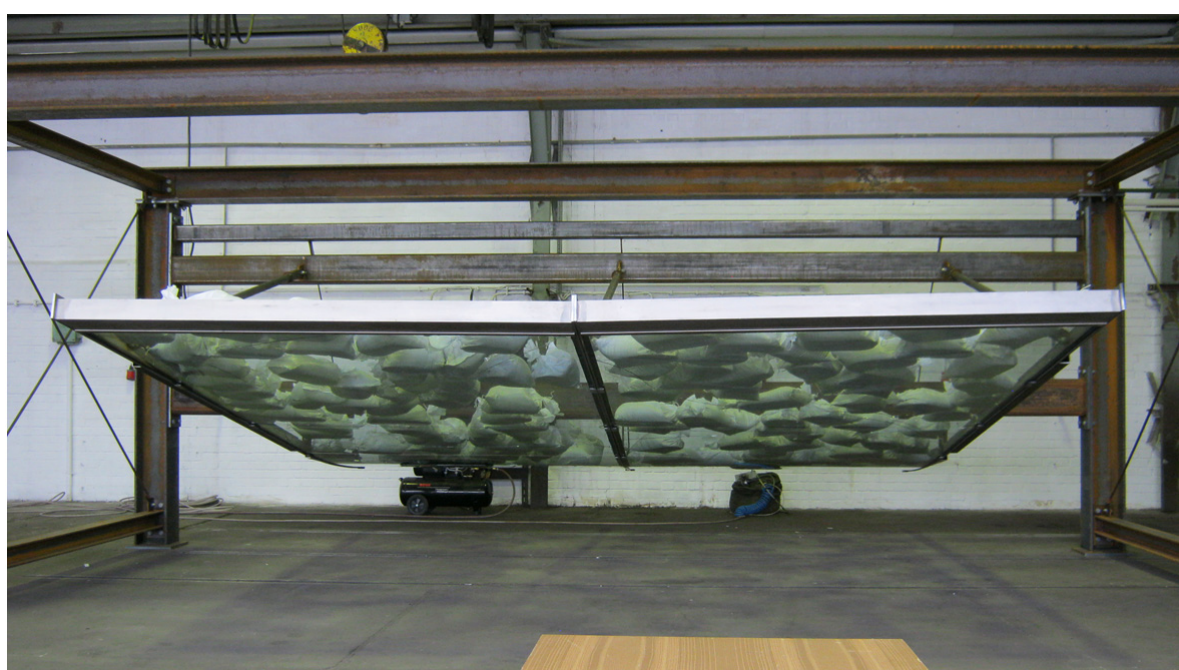
Fig. 13 Test for post breakage